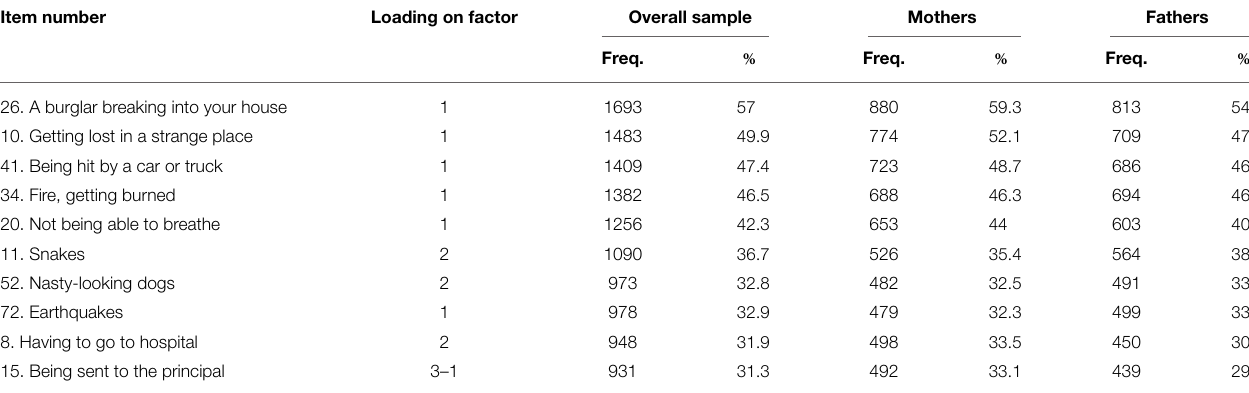
TABLE 6 | Most frequently endorsed fears with greatest intensity for overall sample ( N = 2970 ), mothers ( N = 1485 ) and fathers ( N = 1485 ). Item number Loading on factor Overall sample Mothers Fathers Freq. Freq.